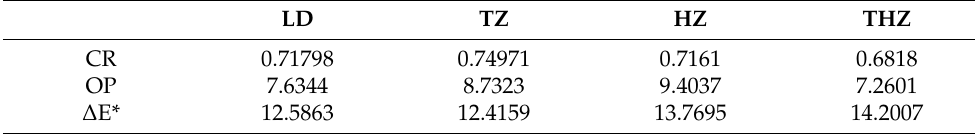
Table 2. Average measurements of ∆ E*, CR, and OP for each material studied.